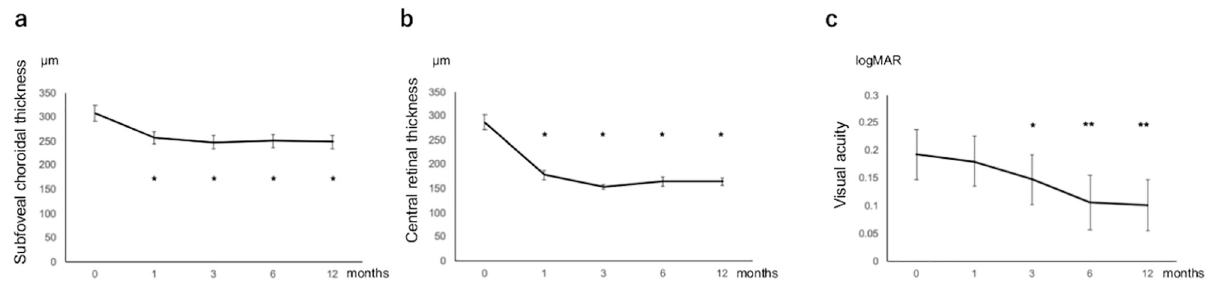
Fig 1. Changes in subfoveal choroidal thickness (a), central retinal thickness (b), and best-corrected visual acuity (c) during the 12-month follow- up period in eyes with pachychoroid neovasculopathy. Each eye was treated with photodynamic therapy combined with intravitreal injections of an